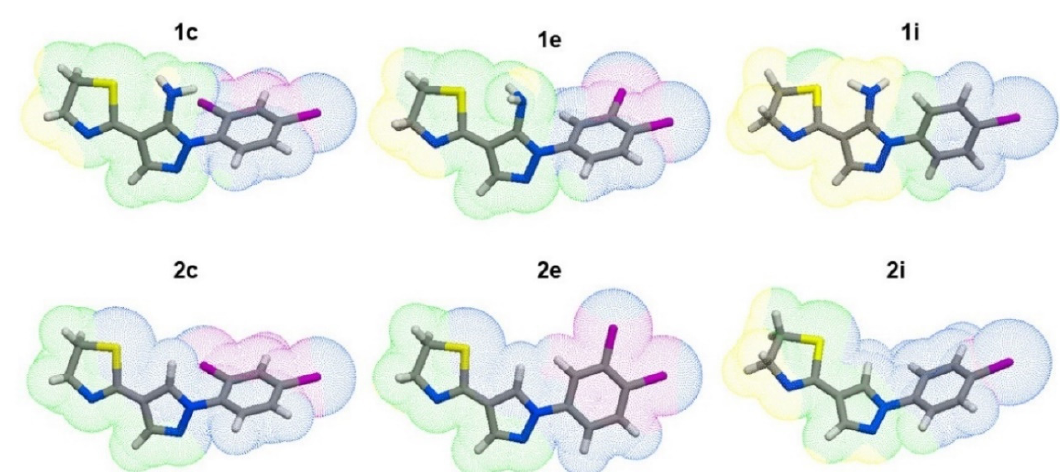
Figure 4. The molecular lipophilicity potential (MLP) of the promising pyrazole-thiazoline derivatives. Blue-violet color indicates the hydrophobic surface, intermediate lipophilic surfaces are coded by green, and yellow-orange colors represent the hydrophilic surface. Three-dimensional images were generated by Molinspiration Galaxy 3D Structure Generator v2018.01 beta (www.molinspiration.com, accessed December 10, 2021).